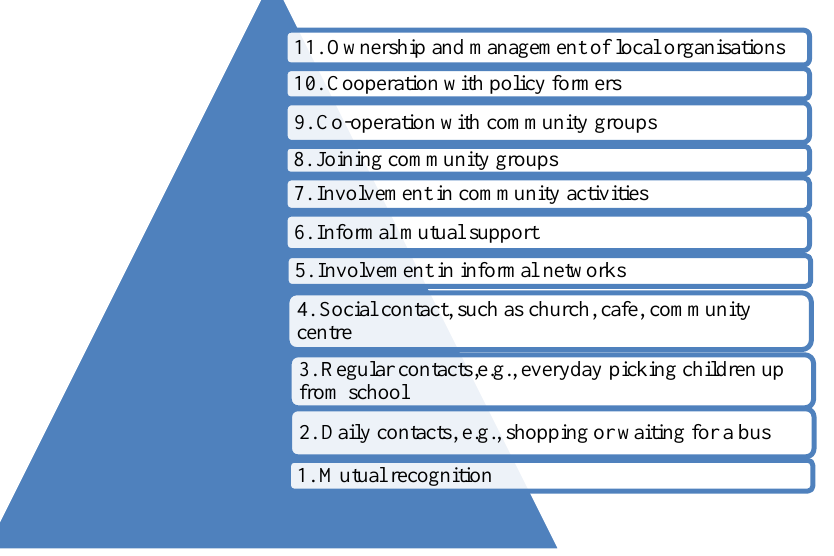
Fig. 1. Community interaction scale (Ušča, 2013) (Figure created by